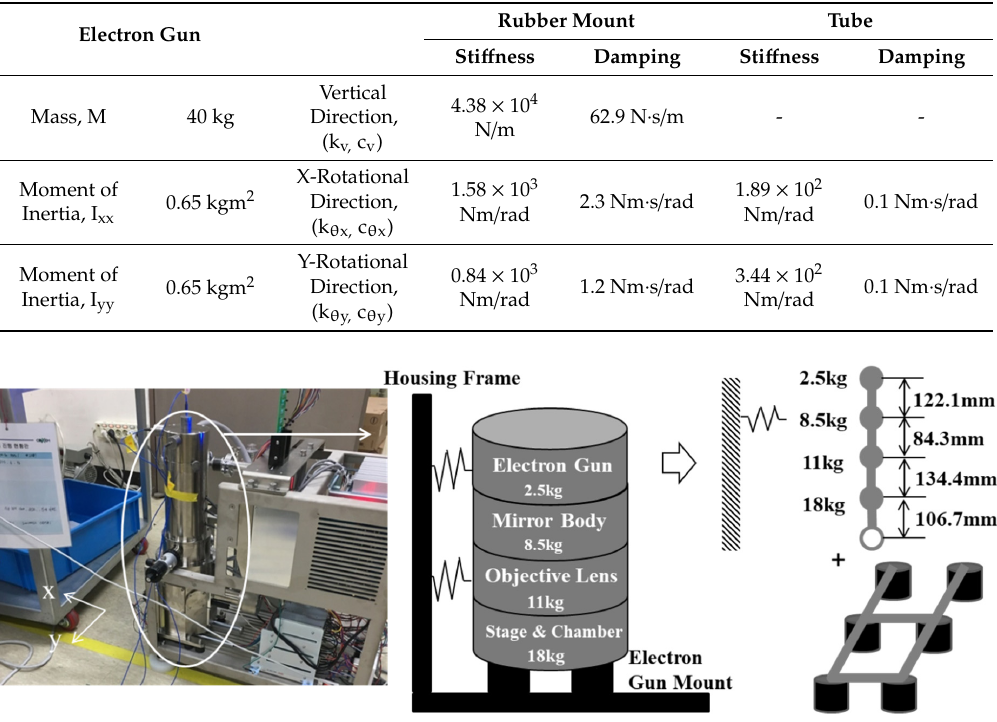
Figure 13. Simplified mathematical model of the electron gun–rubber mount system in the scanning electron microscope (SEM).